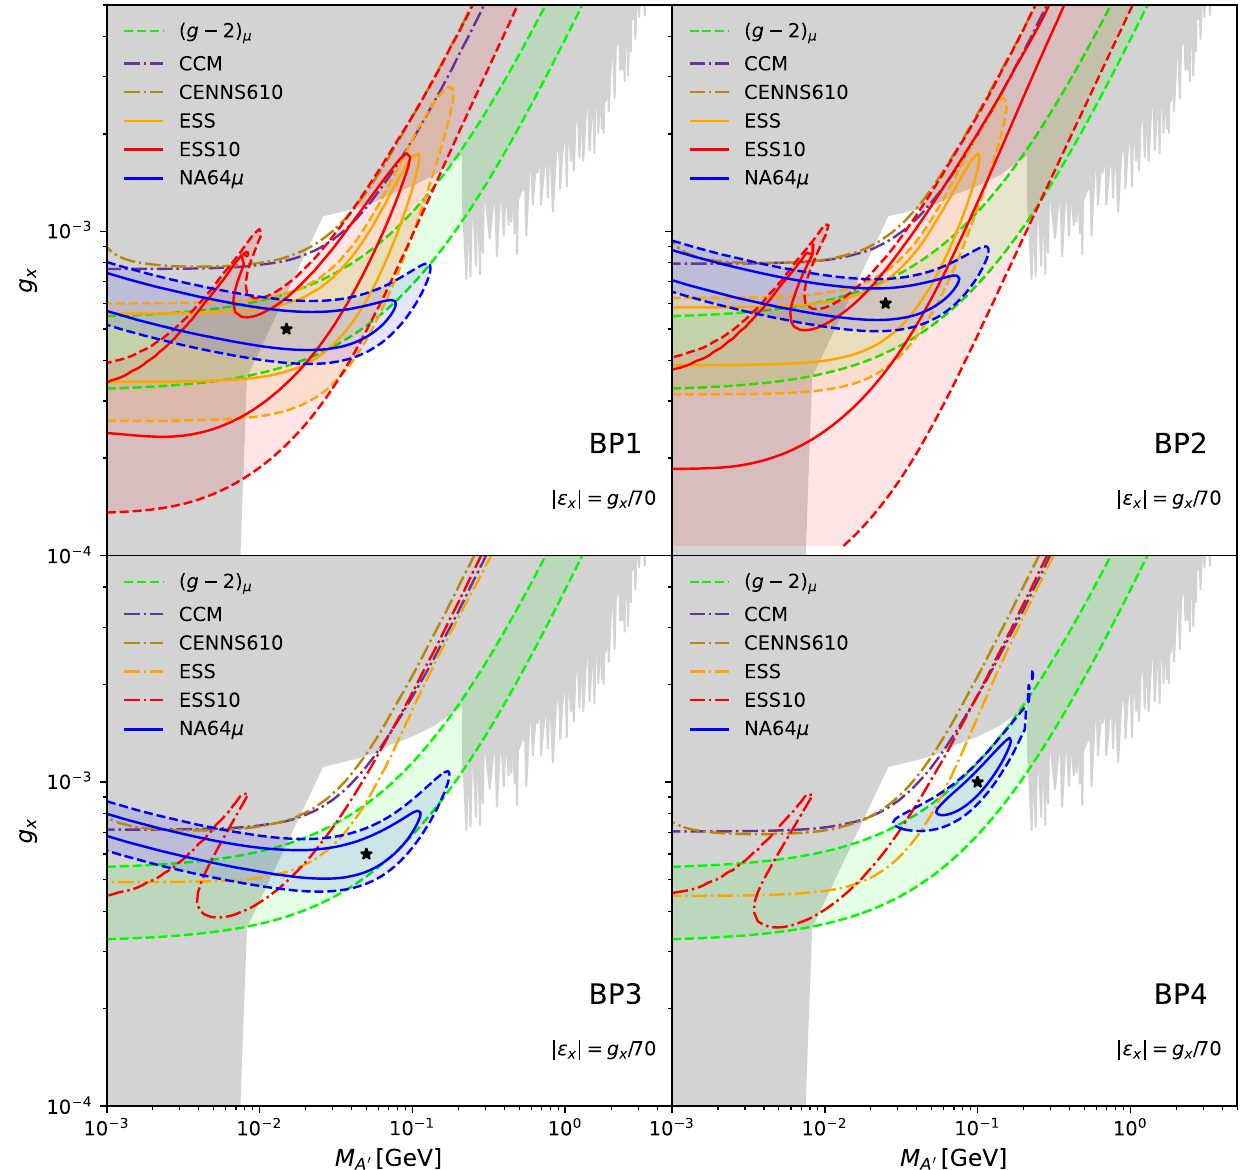
Fig. 8 The same as in Fig. 7, but adding data from NA64 μ and interpreting the results in a U ( 1 ) L μ − L τ model. The green band shows the region favoured by the recent ( g − 2 ) μ